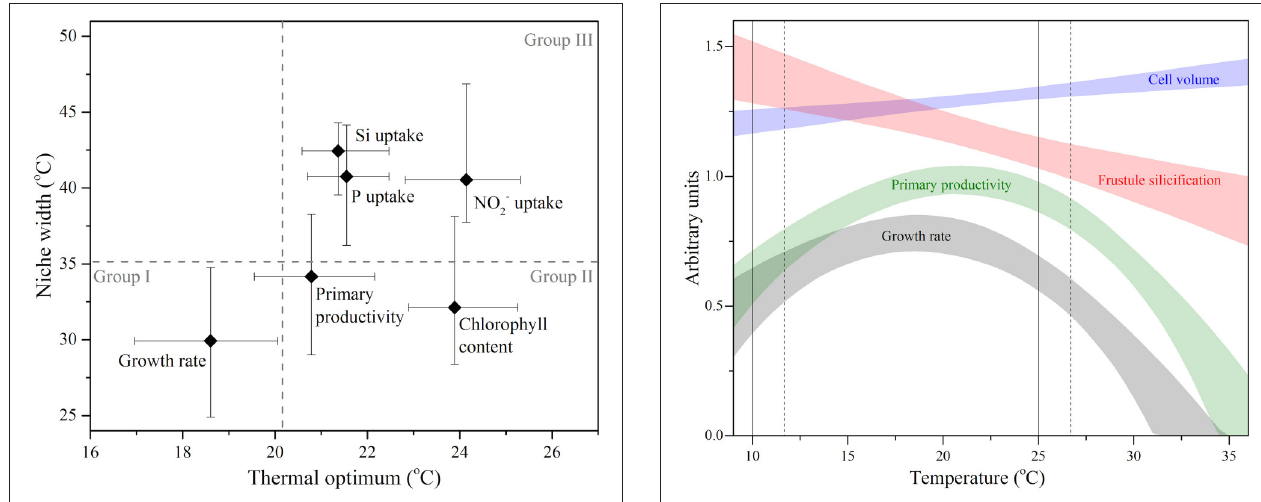
FIGURE 7 | A comparison of the thermal optimum (temperature range over which the maximum trait value is obtained), and niche width (temperature range over which trait value is positive) of various functional traits measured in the diatom Thalassiosira pseudonana, which were parameterized by fitting the bell-shaped function (Equation 1). Symbols represent maximum likelihood estimate and error bars correspond to the 95% confidence intervals, both estimated by parametric bootstrapping corresponding to values in Table 1 . Functional traits are sub-categorized into three groups (Group I, II, and II) separated by the upper 95% confidence interval for the thermal optimum and niche width for growth (broken gray lines).